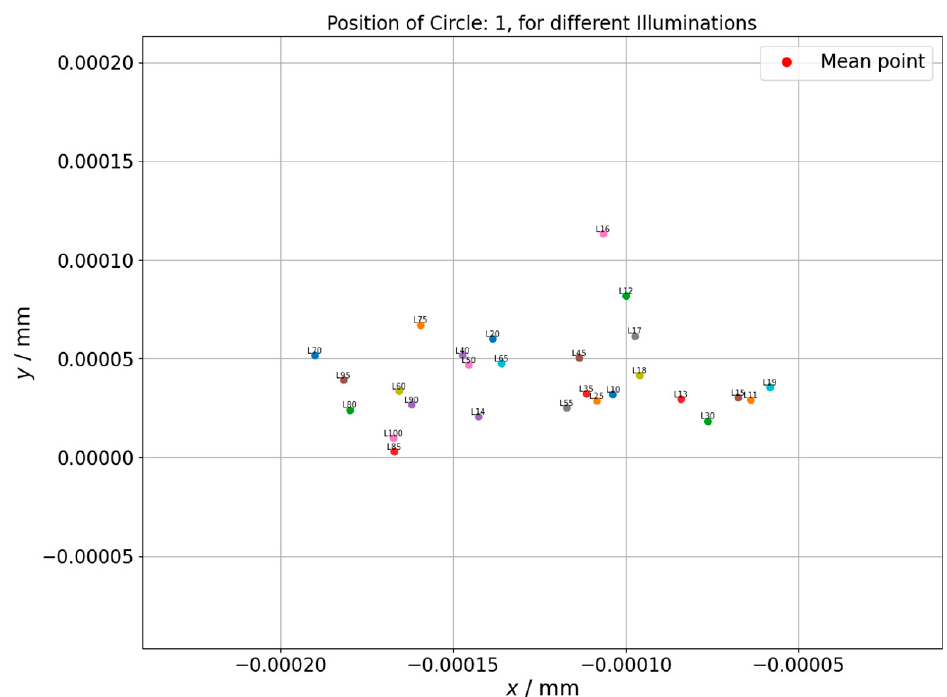
Figure 8. Changes of circle center position depending on the applied backlight. Hole plate standard measurement. Circle 1.